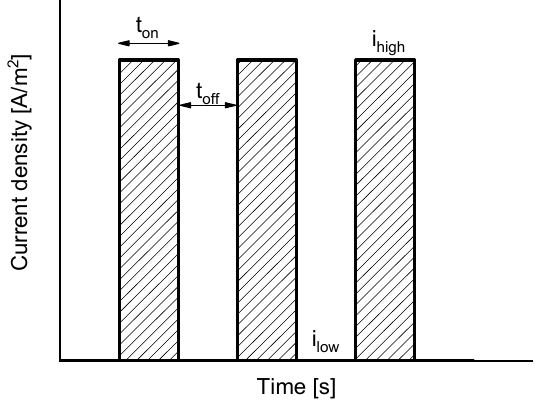
Figure 2. Scheme of the input functions of applied current density.